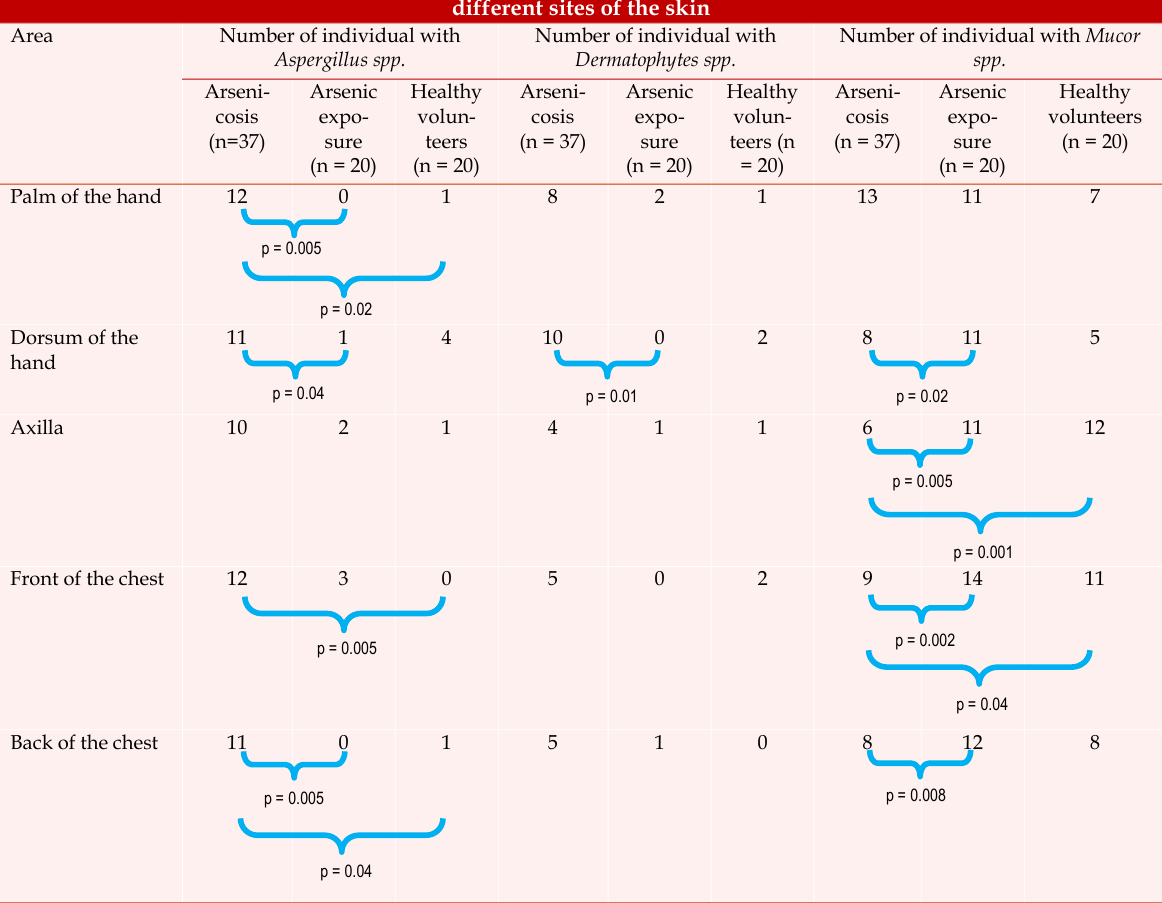
Number of individuals showed the presence of Aspergillus, Dermatophytes and Mucor spp. in five different sites of the skin Number of individual with Aspergillus